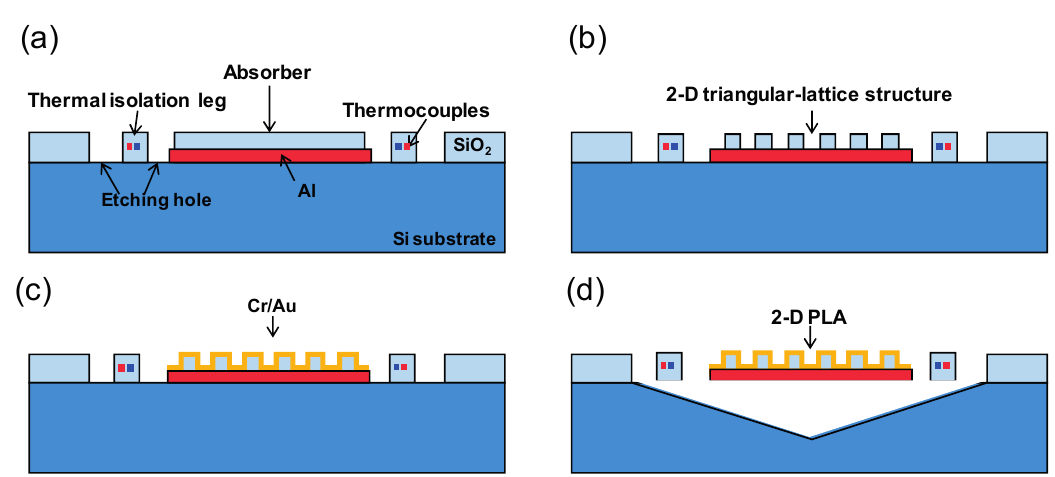
Figure 3. Procedure for the fabrication of a thermopile with triangular lattice 2-D PLAs. ( a ) Devices are formed on the surface of a Si wafer by a standard CMOS process. Etching holes are formed by RIE; ( b ) The 2-D triangular-lattice structures are formed on SiO 2 using a dry etching process; ( c ) Cr/Au layers are sputtered; ( d ) The cavity is formed by TMAH etching.